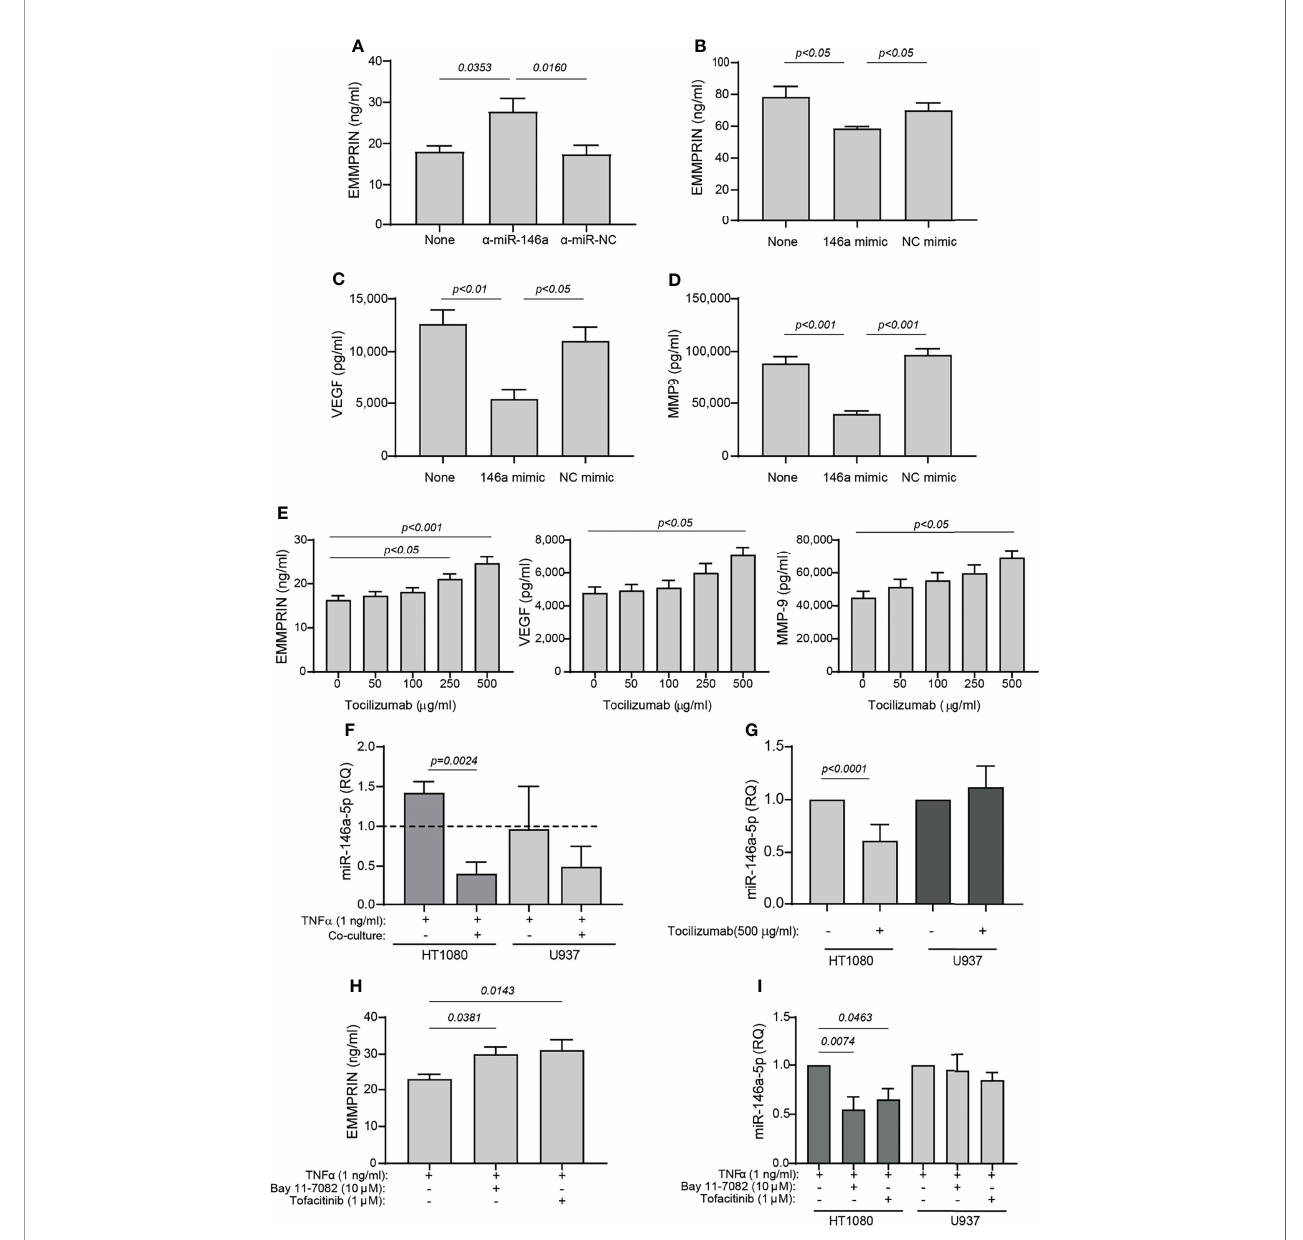
FIGURE 7 | TCZ affects the expression levels of miR-146a and EMMPRIN. (A – D) HT1080 cells (10 4 cells/well in 100 m L) were transfected with (A) anti-miR-146a-5p or its negative control, or with (B – D) miR-146a-5p mimic or its scrambled negative control (NC mimic). After transfection, cells were co-cultured with U937 cells with the addition of TNF a (1 ng/ml), and 48 hours later the concentrations of (A, B) EMMPRIN, (C) VEGF and (D) MMP-9 were determined by ELISA. The one-way ANOVA test, followed by the Bonferroni ’ s multiple post-hoc comparison test were used to assess the effects of the mimic and anti-miR-146a (n=5-6 for each group). (E) Increasing amounts of TCZ were added to HT1080 and U937 co-cultures with TNF a (1 ng/ml), and the concentrations of EMMPRIN, VEGF and MMP-9 were determined by ELISA. The one-way ANOVA test, followed by the post-hoc Dunn ’ s multiple comparison test were used (n=13 in each group). (F) Total RNA was extracted from HT1080 or U937 cells that were co-cultured with or without TNF a (1 ng/ml), and the expression levels of miR-146a-5p were determined in each of the cell types compared to single cultures without TNF a (dashed line). The unpaired student t test was used to compare between groups within each cell line. (n=5 in each group). (G) Expression levels of miR-146a-5p in co-cultures of HT1080 and U937 cells with or without the addition of TCZ (500 m g/ml) were determined in each cell type. The student t test was used to compare between the groups in each cell line (n=9-10 in each group). Lastly, HT1080 and U937 cells were incubated in co-culture for 48 hours in the presence of TNF a (1 ng/ml), with or without the NF- k B inhibitor Bay 11-7082 (10 m M) or the JAK/STAT inhibitor Tofacitinib (1 m M). (H) EMMPRIN concentrations and (I) miR-146a-5p expression levels were determined. The one-way ANOVA test, followed by the Bonferroni ’ s multiple post-hoc comparison test were used to assess the effects of the inhibitors on EMMPRIN and miR-146a expression